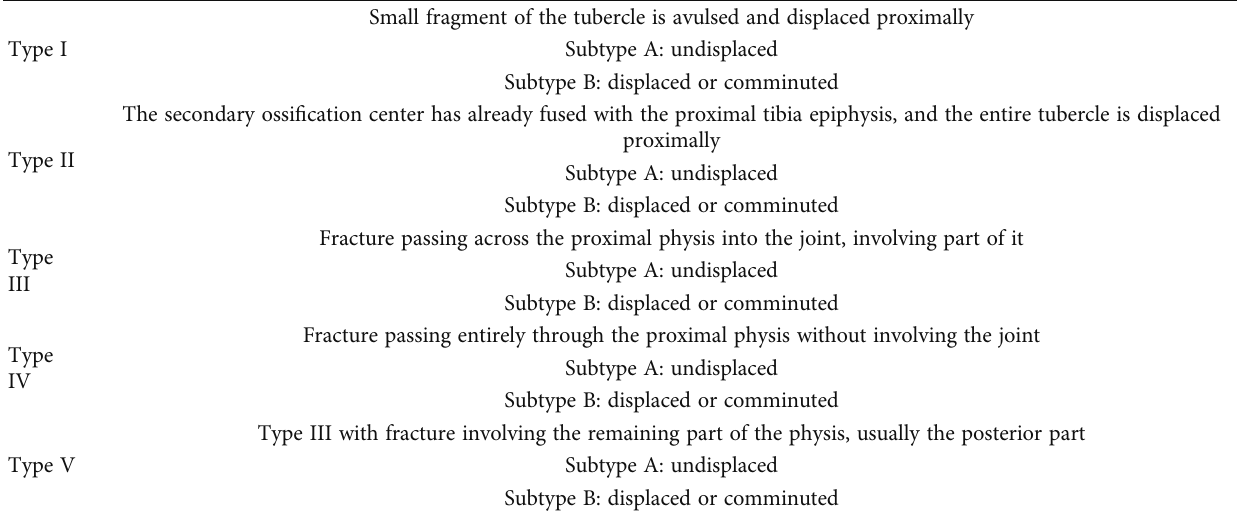
Figure 5: Photographic images demonstrating complete patellar tendon distal detachment. Table 1: Anterior tibial tubercle fracture